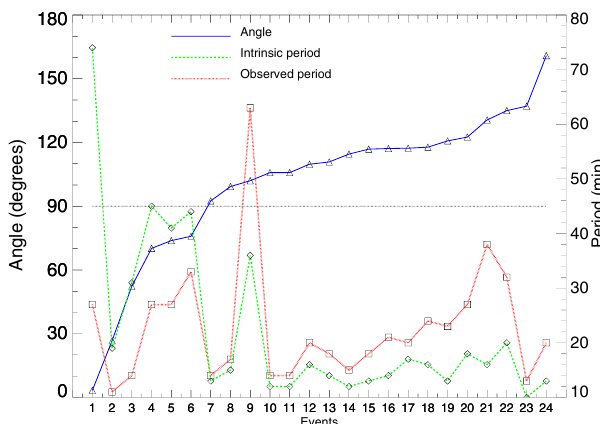
Figure 4. Diagram for the angle between the propagation of pe- riodic wave and wind vector for all 24 waves. The observed and intrinsic periods are shown on the right vertical